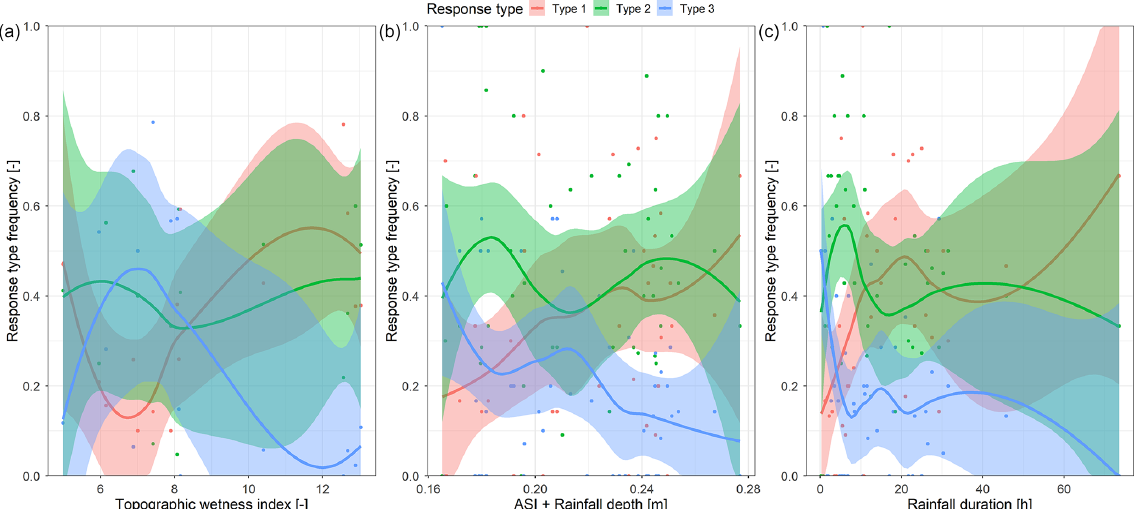
Figure A2. Groundwater response-type frequency over station topographic wetness index (a) , a sum of antecedent wetness (ASI) and event rainfall depth (b) and rainfall event duration (c) . Colours represent different response types as defined in Sect. 2.6. Points are calculated values of response-type frequencies; lines are local regression fits for each response type and the shaded areas corresponding to 95% confidence